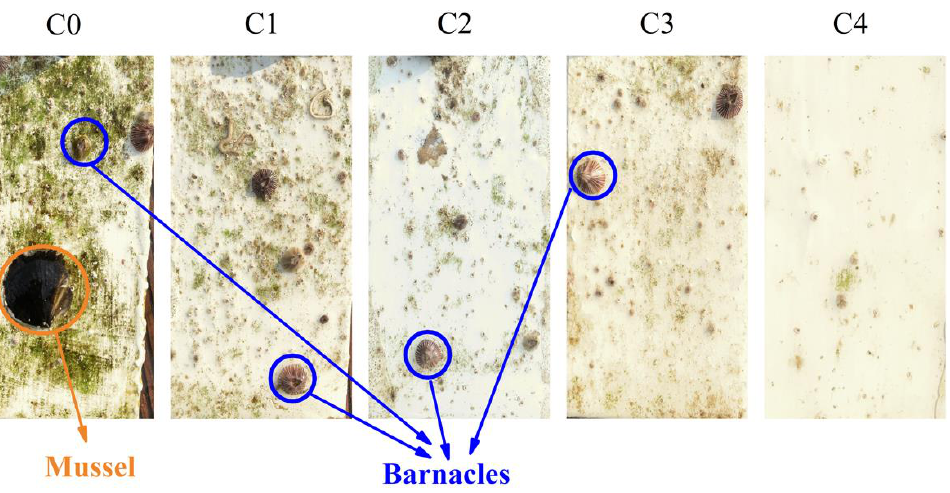
Figure 8. Coating surface fouling and adhesion after immersion for 120 days. (C0: ZA; C1: ZnO/ZA; C2: ZnO − APTES/ZA; C3: ZnO − APTES − F/ZA; C4: ZnO − APTES − TRF/ZA).